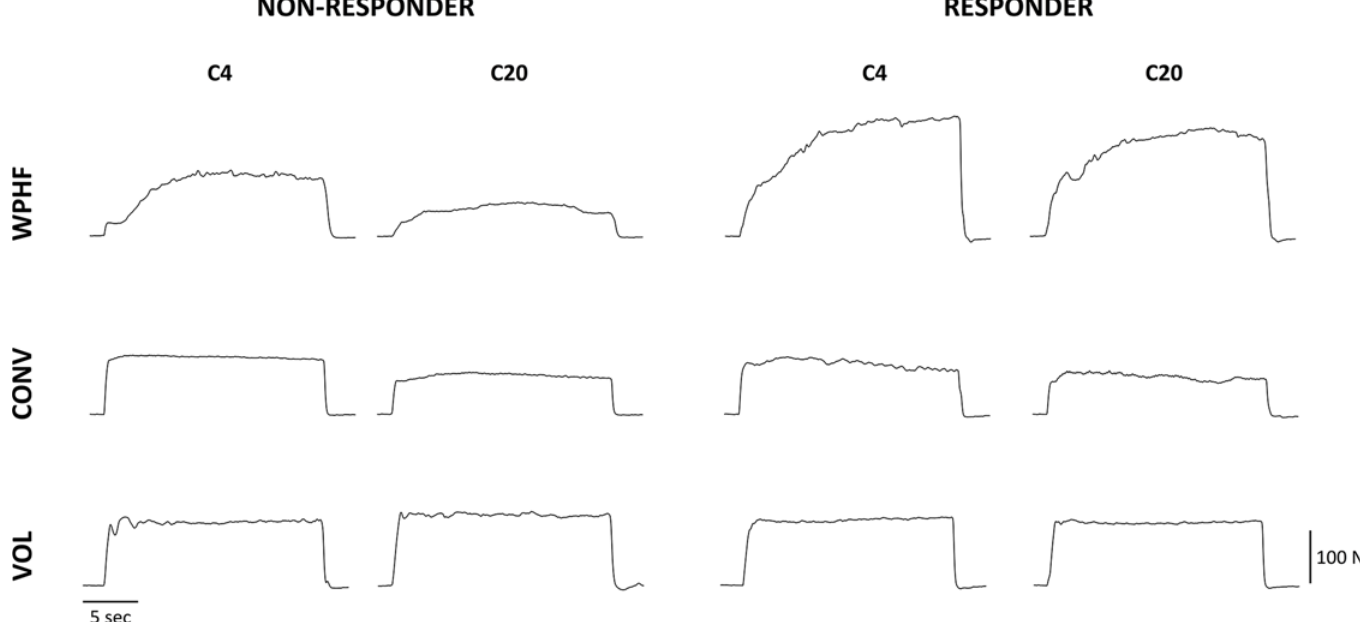
Fig 3. Representative force generation profiles during the first four (C4) and the last four (C20) contractions of the WPHF, CONV and VOL protocols for one non-responder (A) and one responder subject with similar MVC values Note that force production was higher and fatigue was lower for the responder as compared to non-responder during the WPHF